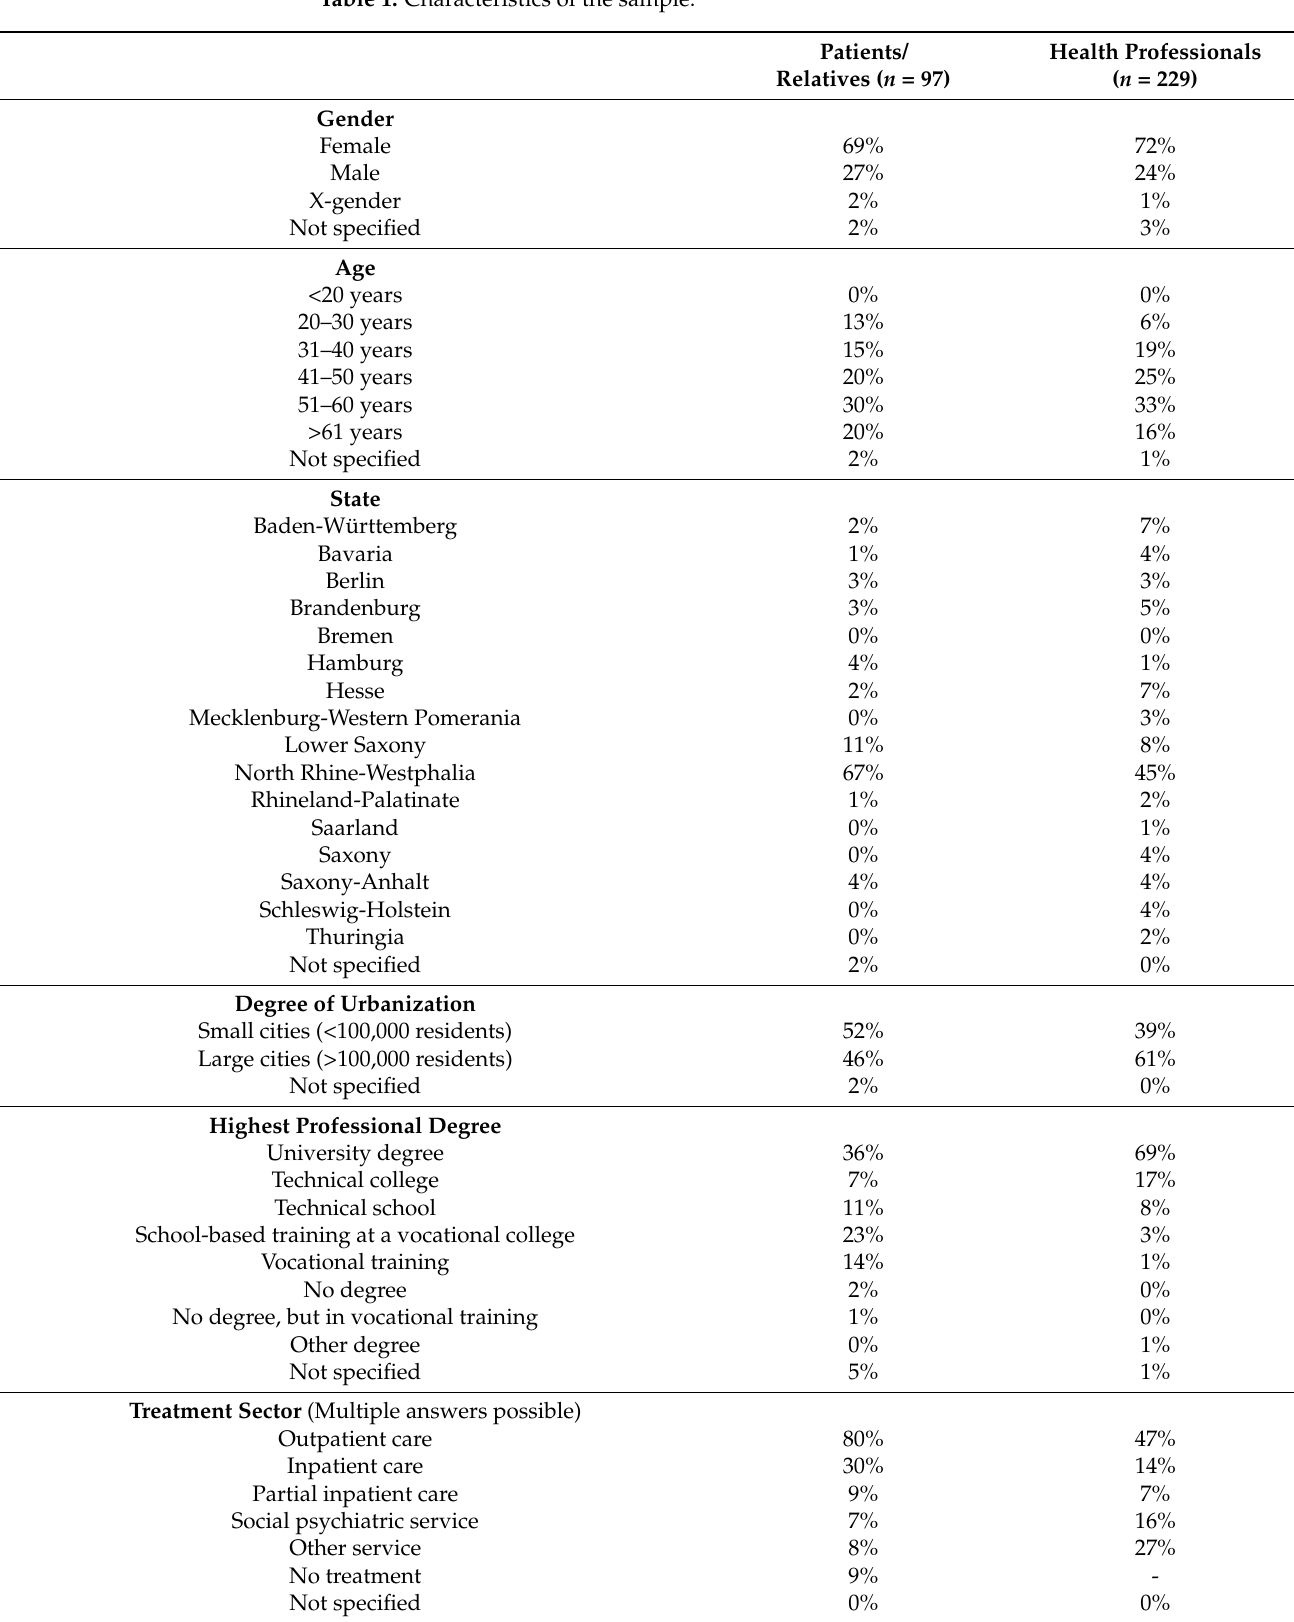
Table 1. Characteristics of the